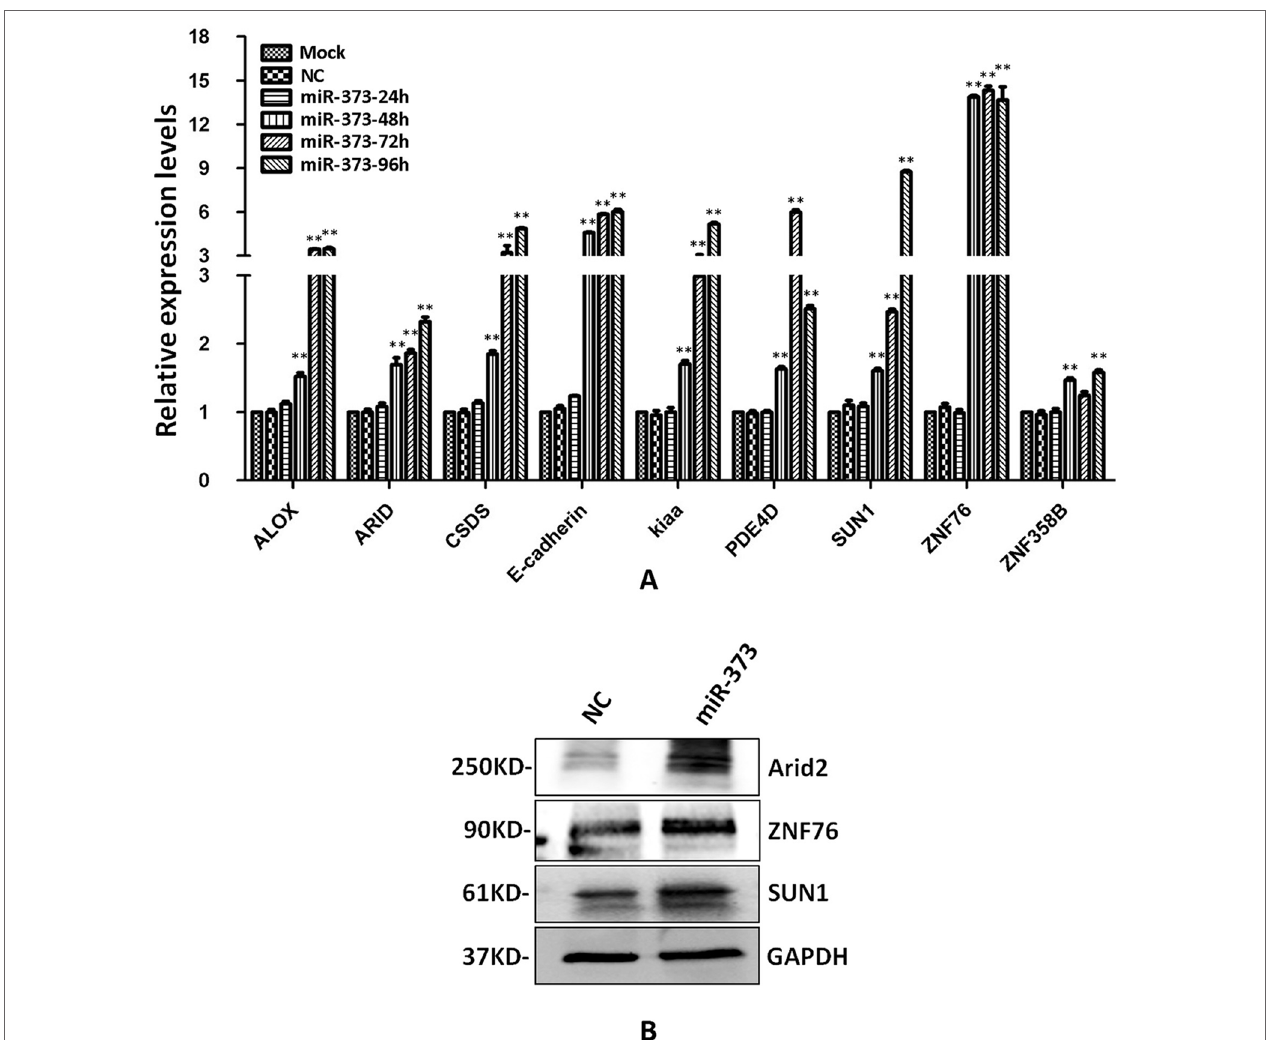
FIGURE 4 | The identified genes can be regulated by miR-373. (A) MCF-7 cells were transfected with miR-373 or NC-miRNA. Cells were harvested after 24, 28, 72, or 96 h post-transfection. Real-time PCR was used to measure the mRNA level of identified genes. The expression of β -actin was used as the internal reference. n = 3, ** P < 0.01 compared with the sample transfected with NC miRNA. (B) MiR-373 or NC-miRNA was transfected into MCF-7 cell for 72 h. The protein levels of identified genes were detected by Western